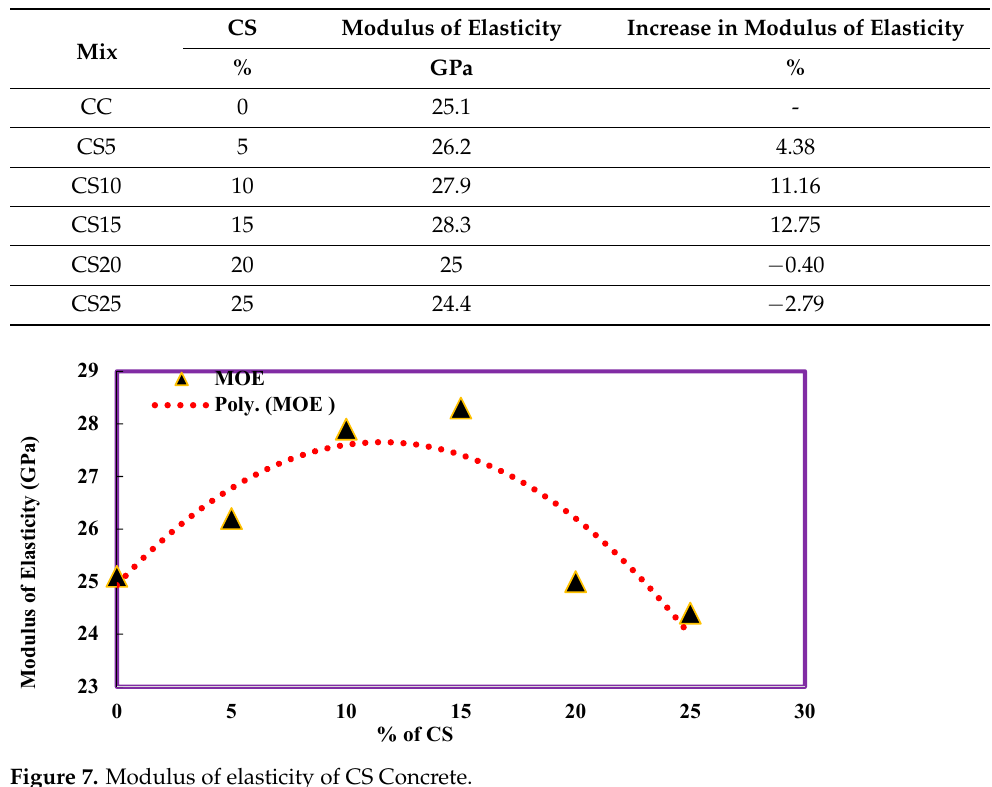
Table 6. Modulus of elasticity of CS concrete.